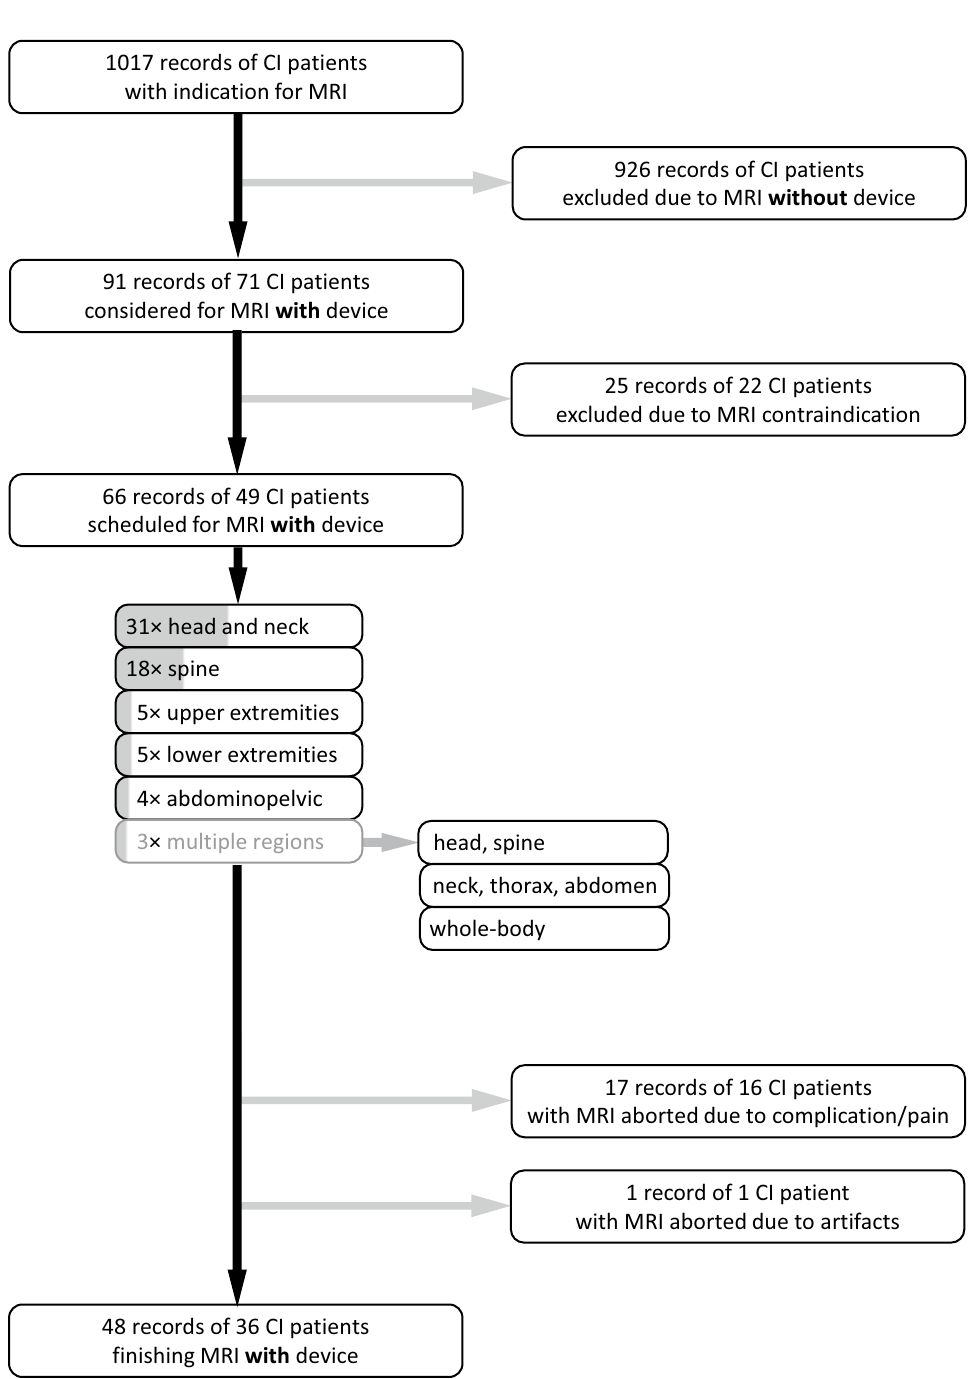
Fig. 2 Flowchart of patients with a cochlear implant (CI) and MRI examinations between 2001 and 2018 from a single tertiary center and breakdown into body regions for scans with the CI